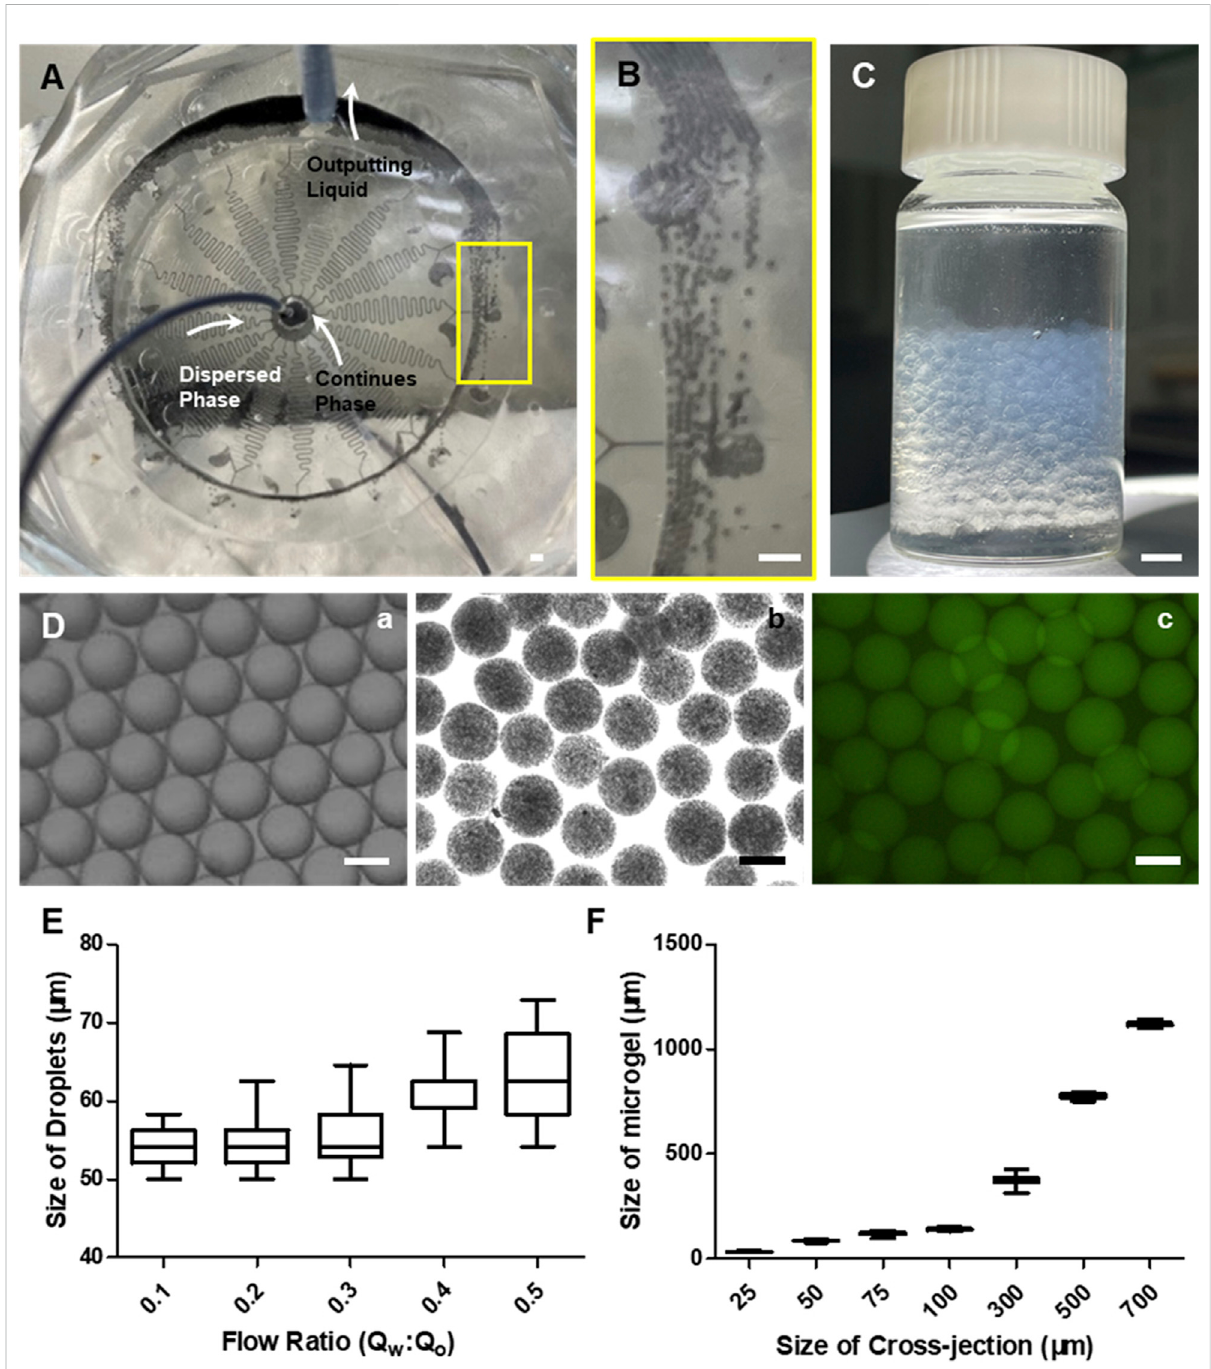
FIGURE 3 Experimental data of the integrated chip for large-scale production of alginate microgels. (A) Photograph showing the integrated micro fl uidic chip connected by inlet and outlet tubes during microgels preparation. Scale bar is 1 mm. (B) The local view showing the fl ow state of the mixture of continues phase and microgels within connection channel. Scale bar is 1 mm. (C) Photograph showing the output liquids collected 16× DMUs integrated chip for 5-min fabrication. Scale bar is 1 mm. (D) Representative bright fi eld of microscopic images of micro-droplets (A) and microgels (B) and confocal microscopic images (C) for microgels generated by integrated micro fl uidic chips. FITC-polystyrene nanoparticles were encapsulated inmicrogels. Scale bars are 100 µm. (E) The size distribution oftheresultingdropletsproducedwith different fl owrate ratios Q aqu /Q oil at a fi xed Q oil (16 ml h − 1 ). (F) The size distribution of the resulting microgels produced with different channel sizes at a fi xed fl ow rate ratios Q aqu / Q oil